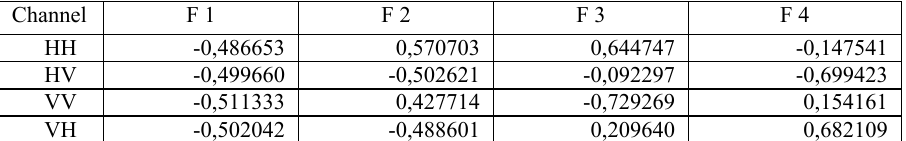
Table 3 . Eigenvectors of the correlation matrix in the scene with the target.